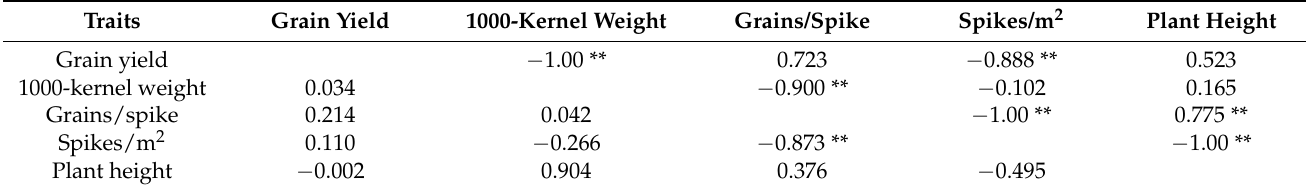
Table 5. Phenotypic (below diagonal) and genotypic (above diagonal) correlation coefficients between grain yield and agronomic traits for seven examined barley genotypes across three tillage systems in two locations and two cropping seasons under rainfed